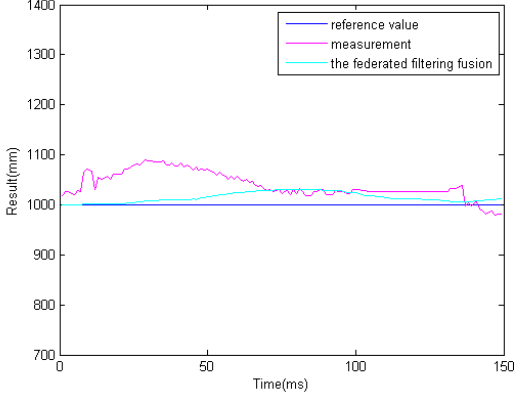
Figure 17. The results of information fusion based on an adaptive Kalman filter using binocular cameras and two ultrasonic sensors at 1.0 m.